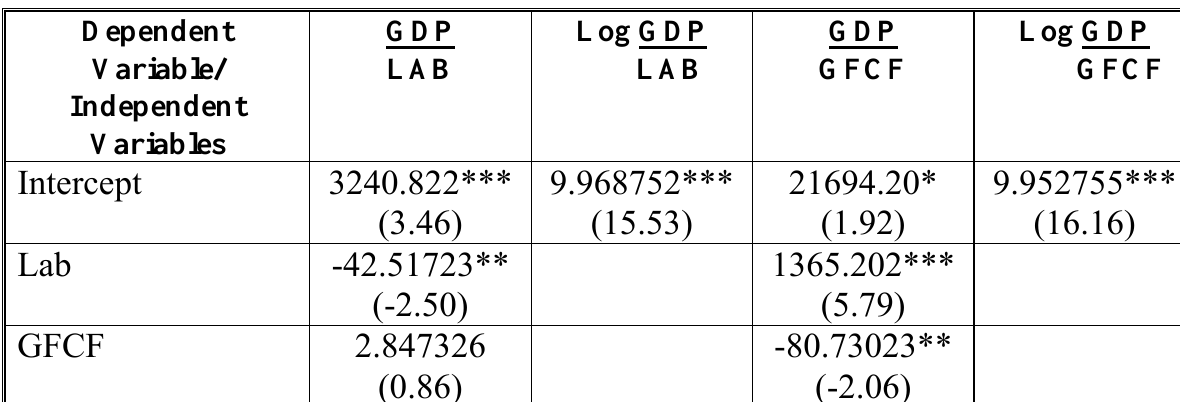
Time series estimate of restricted translog specification